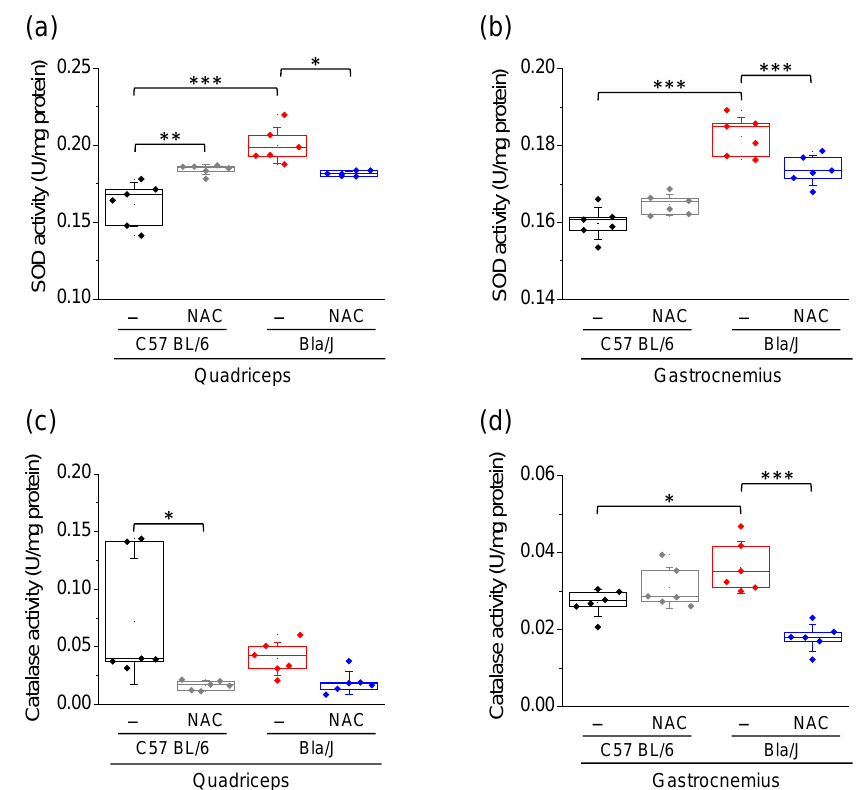
Figure 2. Effects of NAC on SOD and catalase activity in quadriceps and gastrocnemius of dysferlin-deficient Bla / J mice. SOD ( a , b ) and catalase ( c , d ) activities were measured in quadriceps (left panels) and gastrocnemius (right panels) of C57 BL / 6 or Bla / J mice untreated or treated with 1% NAC for 10 weeks. Boxes indicate 25–75 percentiles of SOD or catalase activities, lines within boxes indicate medians, and whiskers indicate SD. Each dot represents an individual sample (six mice per group). * p < 0.05; ** p < 0.01; *** p < 0.001 (one-way ANOVA, followed by Tukey-Kramer multiple comparisons test). All data pass the Kolmogorov–Smirnov normality test.